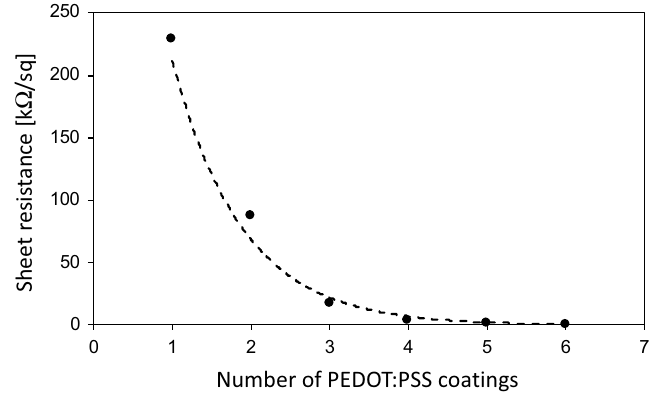
Figure 5. The sheet resistance, R sq , of the multiple PEDOT:PSS coatings as a functions of the number of coatings, n. An exponential dependence between R sq (n) and n is found and can be expressed as R sq (n) = 230 exp[− (n − 1) 1.28]